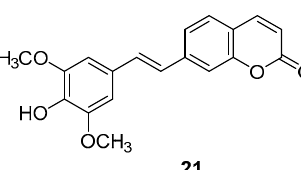
Figure 10. Chemical structure of styrylcoumarin 21 .